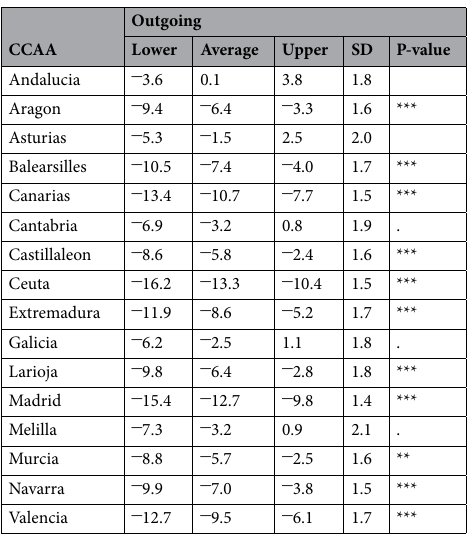
Table 8. Bayesian structural time series estimates. All values in %. 1 *** 0.1%, ** 1%, * 5%, . 10% significance levels.